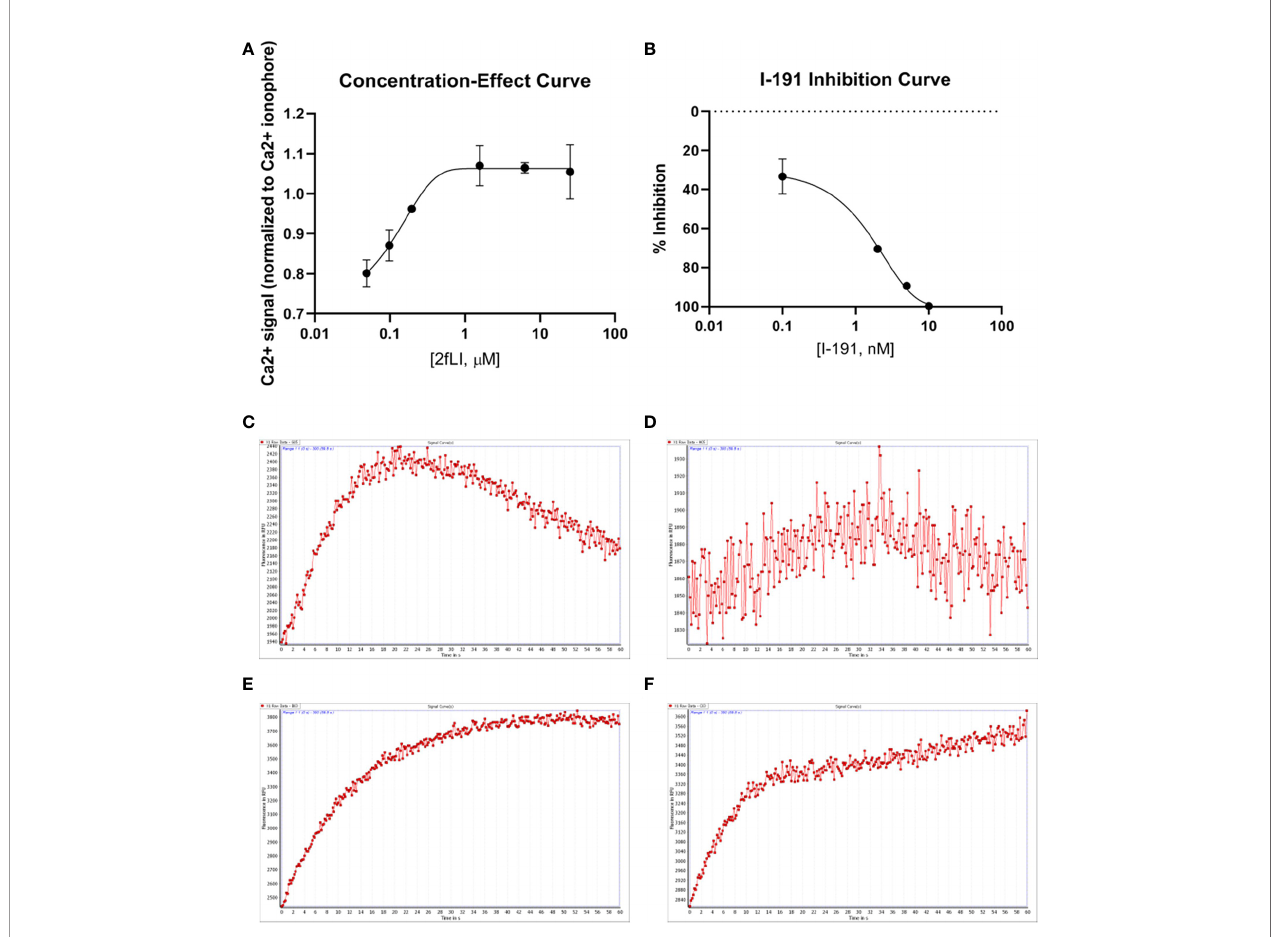
FIGURE 6 | PAR2 and tryptase-6 trigger calcium signals in HEK-293 cells. Calcium signaling assay using the fl uorescent indicator, Fluo-4 AM, was used to con fi rm the signaling potential of PAR2 and determine whether tryptase-6 can elicit a calcium response via PAR2 in HEK-293 cells. The concentration-effect curve for the PAR2 agonist 2fLI with an EC50 of 0.14 µM (A) and the concentration – inhibition curve for the PAR2 inhibitor I-191 with an IC50 of 2.1 nM (B) are shown. Stimulation of cells with 0.15 µM of 2fLI (C) was inhibited 99% by 10 nM of I-191 (D) . Stimulation of cells with 10.0 FU/min/ng tryptase-6 isolated by antibody af fi nity chromatography from PsA SF caused an elevation of intracellular calcium (E) and 10 nM of I-191 caused a 34% inhibition of this signal (F) . Calcium traces are shown with agonists (2fLI and tryptase-6) added at time zero with or without pre-treatment with I-191 (x-axis=time post addition of agonist, y-axis=units of fl uorescence due to calcium